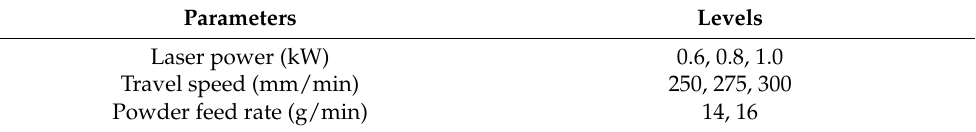
Table 2. Experimental parameters .